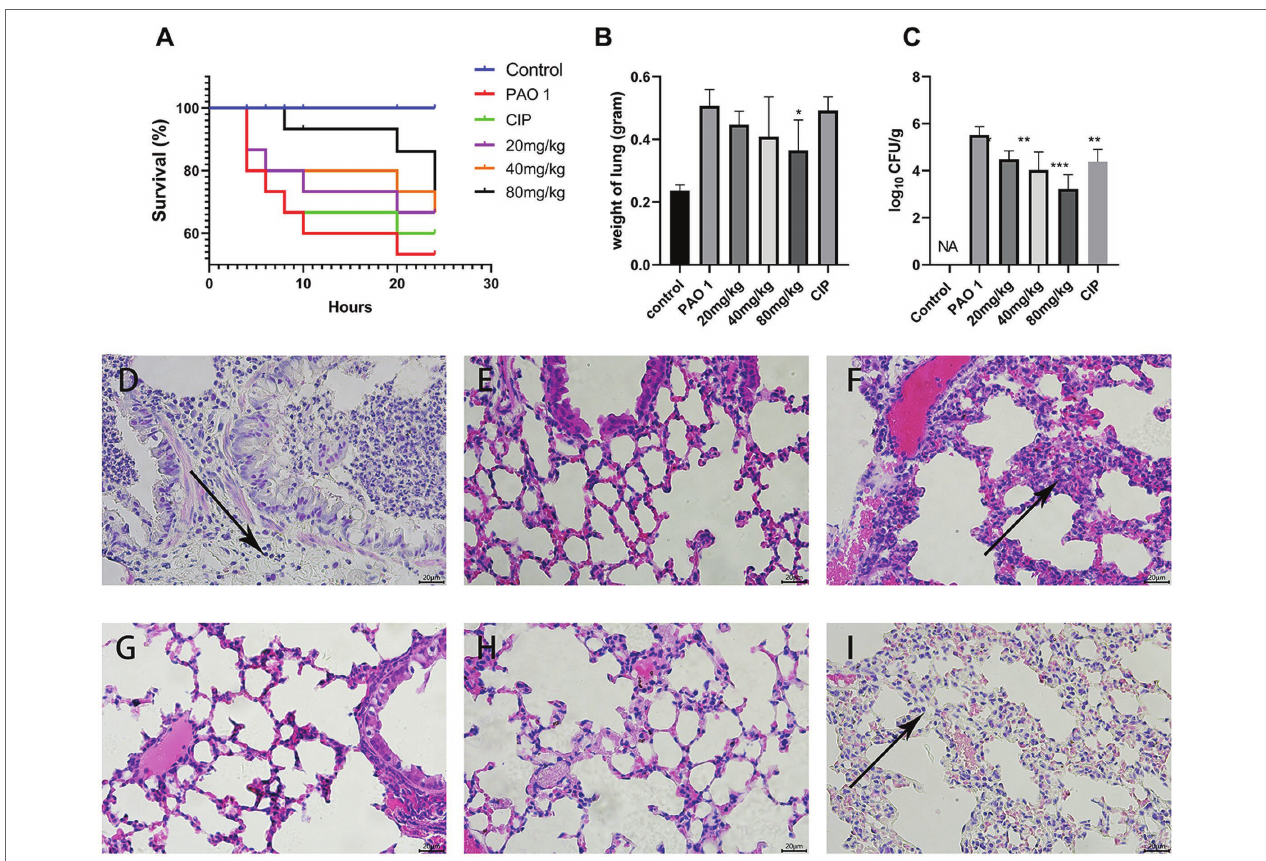
FIGURE 1 | Protective efficacy of EGCG against acute lung infection. (A) The survival rate was measured at different time points post P. aeruginosa challenged. (B) The weight of the lungs after P. aeruginosa challenged. (C) Bacterial load in the lungs were evaluated at 24 h post infection. (D–I) Pathological changes in (D) P. aeruginosa group, (E) control group, (F) EGCG (20 mg/kg) group, (G) EGCG (40 mg/kg) group, (H) EGCG (80 mg/kg) group, (I) CIP was used as positive control. Data are presented as mean ± SD and analyzed with one-way ANOVA. * p < 0.05, ** p < 0.01, *** p < 0.005 vs. PAO 1